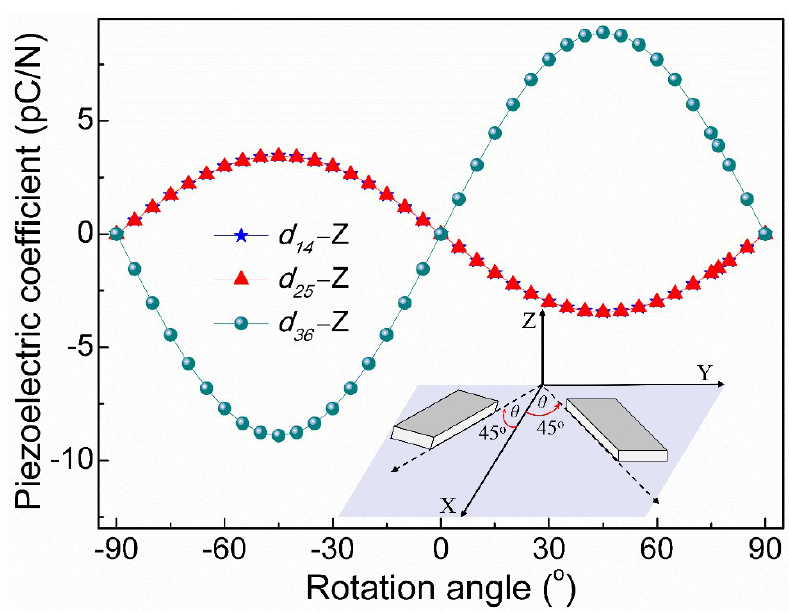
Figure 7. Orientation dependences of piezoelectric coefficient rotated around Z -axis for BZBO crystals. The small inset shows the optimum crystal cuts (( ZXt )/±45° crystal cuts) with the largest d 36 .